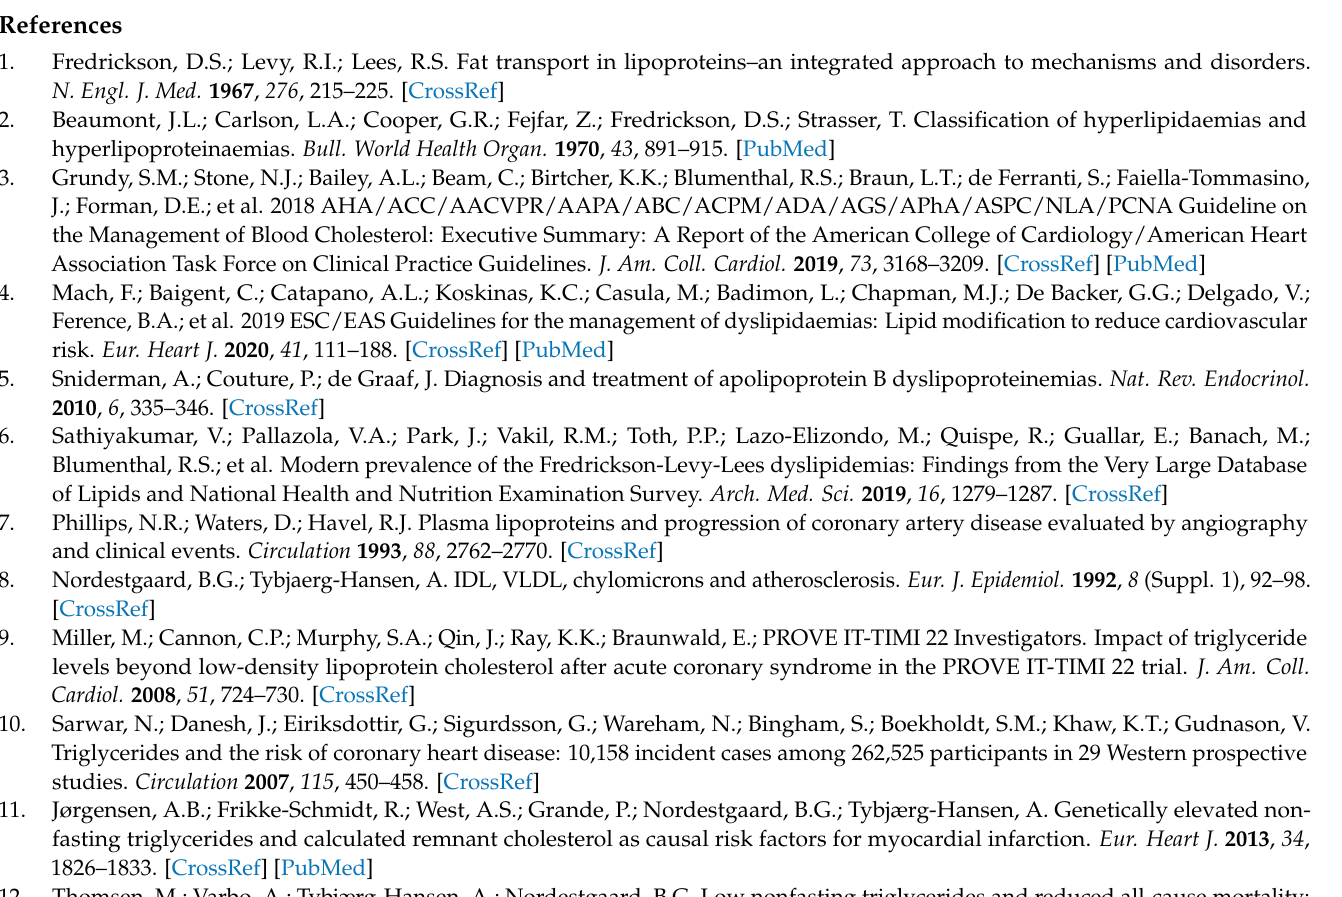
the present study. Figure S1: Illustration of plasma VLDL-C and percentages of change in plasma VLDL-C among